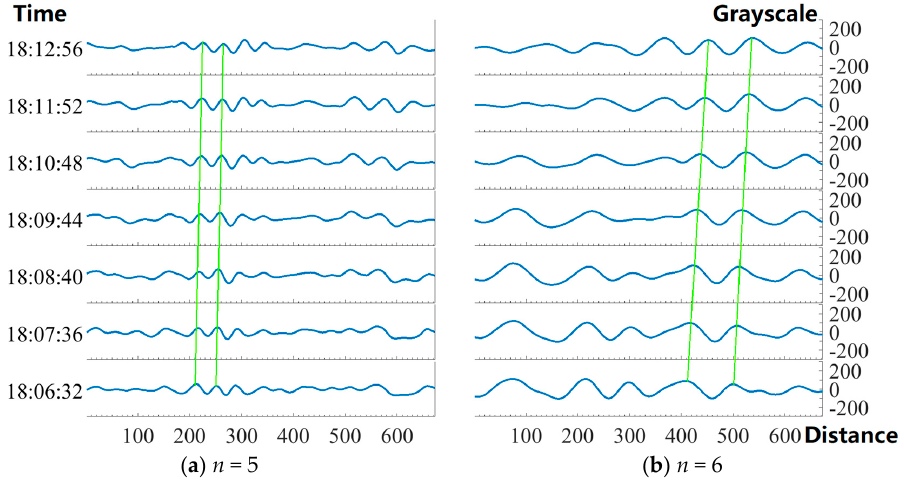
Figure 6. Assembled airglow image after denoising. The axes above and to the right represent the position. The lower and left axes indicate the longitude and latitude, respectively. The ASAI stations are marked with yellow points. This image is obtained by superposing all of the images in Figure 5, showing wave patterns with more visibility than Figure 1. The green arrow indicates the propagating direction of the local GWs, which is perpendicular to most wave surfaces it crosses. Table 2. Wavelength, horizontal speed, and relative fluctuation of quasi-monochromatic GWs with different scales. The values listed are the average and variance of multiple measurements.